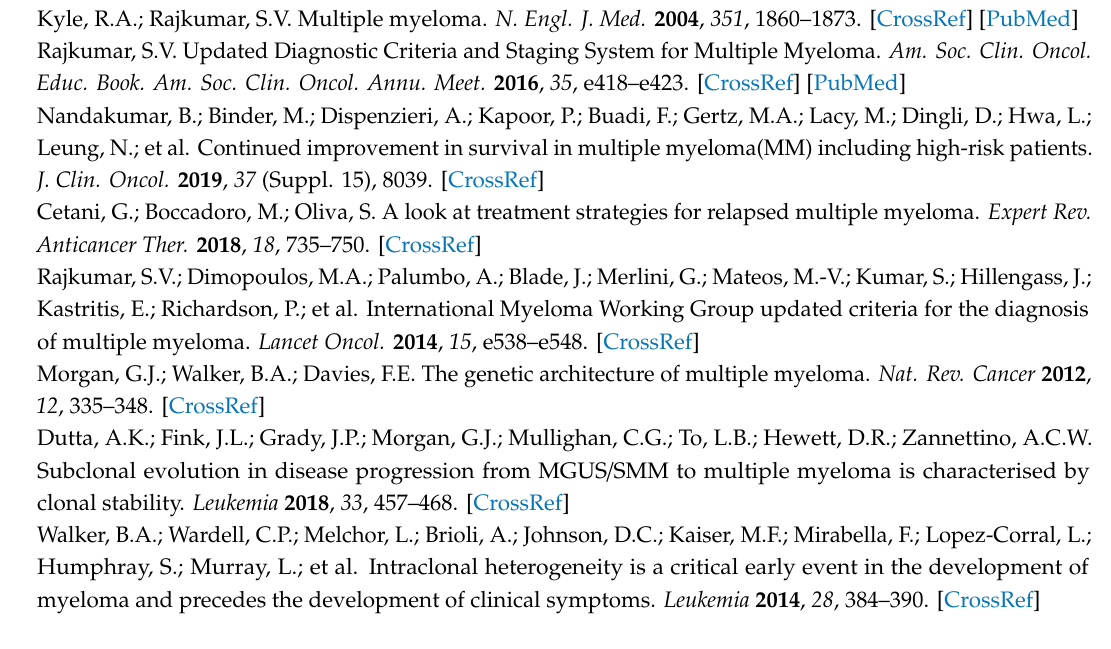
Figure S1: GREM1 expression is elevated in primary stromal cultures from MGUS patients, Figure S2: BMP signaling is downregulated in 5TGM1 MM PCs co-cultured with stromal cells overexpressing Grem1, Figure S3: Blocking Grem1 activity with an anti-Grem1 neutralizing antibody significantly reduces MM PC proliferation in co-culture with BM stroma but not in monocultures of MM PCs in vitro, Figure S4: Anti-Grem1 antibody treatment does not alter the ability of 5TGM1 MM PCs to home to the BM in vivo, Figure S5: Di ff erential Grem1 expression in whole splenic and compact bone isolates, Figure S6: Anti-Grem1 treatment does not alter any hematological parameters in vivo, Figure S7: full western blot, Figure S8. Phospho-Smad1 / 5 / 9 full western blot. Images from same blot taken on consecutive days to account for antibody incubation and intensity of band signals, Figure S9. Phospho-Smad1 / 5 / 9 full western blot. Images from same blot taken on consecutive days to account for antibody incubation and intensity of band